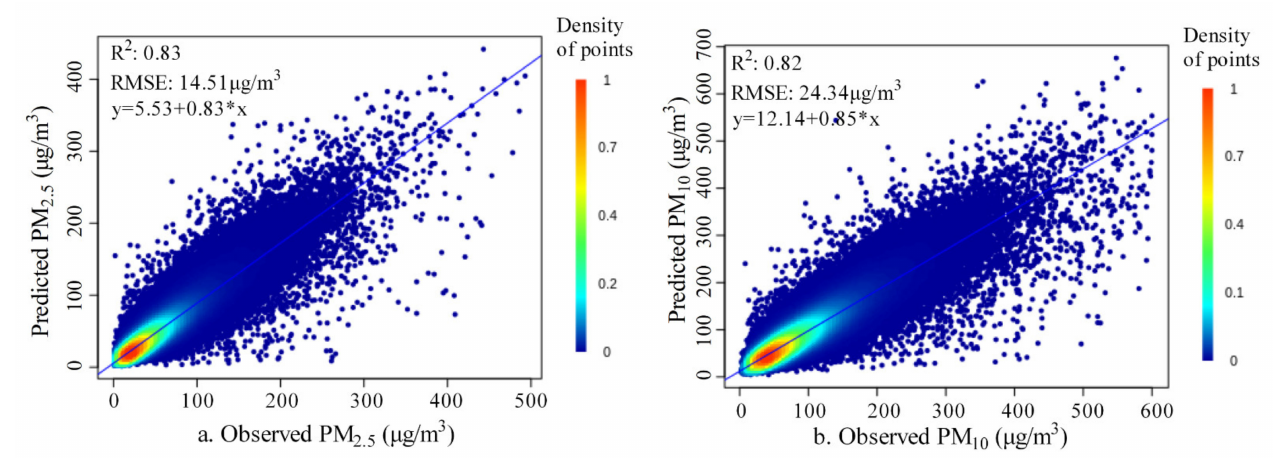
Figure 7. Scatter plots between observed values and predicted values (( a ) for PM 2.5 ; ( b ) for PM 10 ).